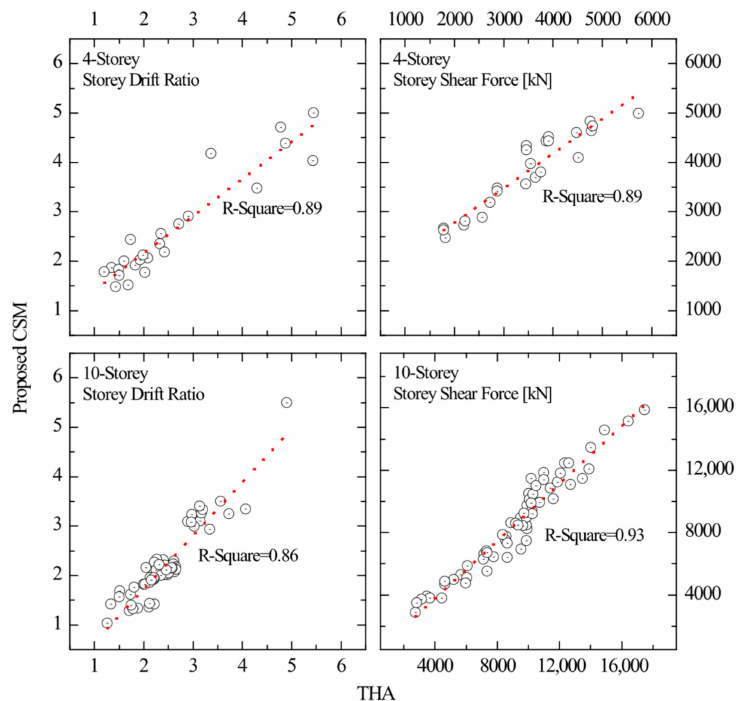
Figure 15. Story drift and shear force correlation of the proposed CSM and nonlinear THA for 4- and 10-story steel